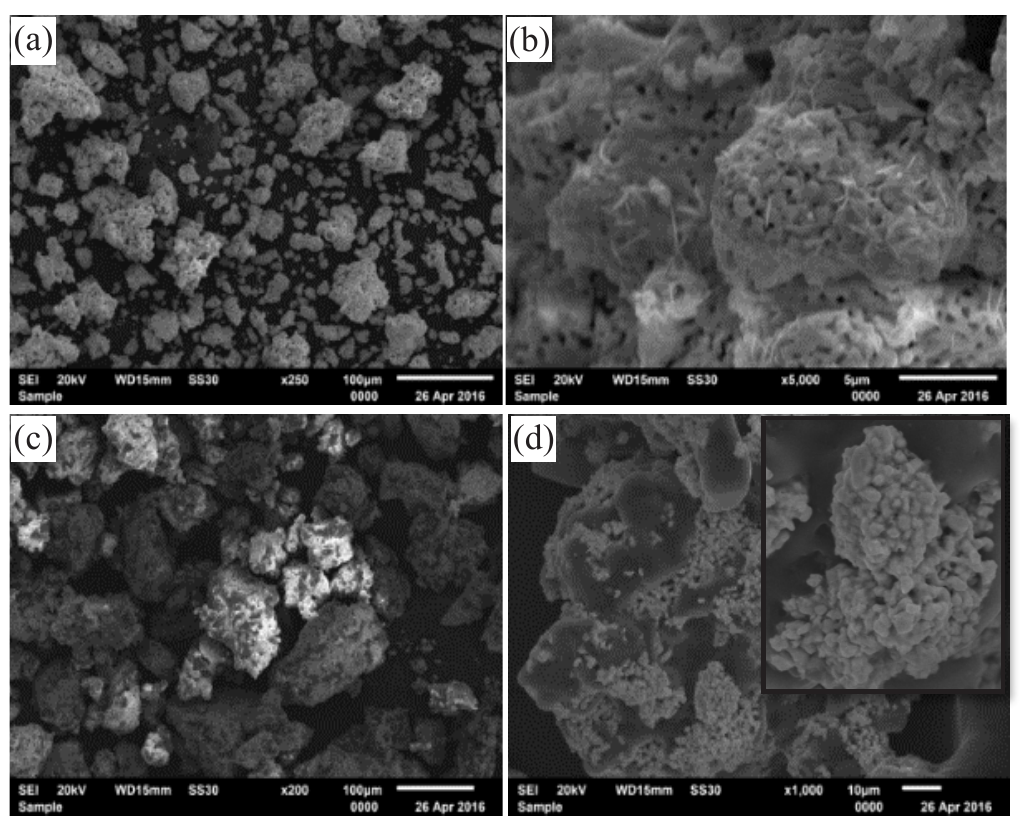
C O and Na CO as precipitation agents. The morphology appearance of 2 2 4 2 3 C O at magnification of a) 250 times and b) 5000 times and of bismuth oxide synthesized using Na 2 2 4